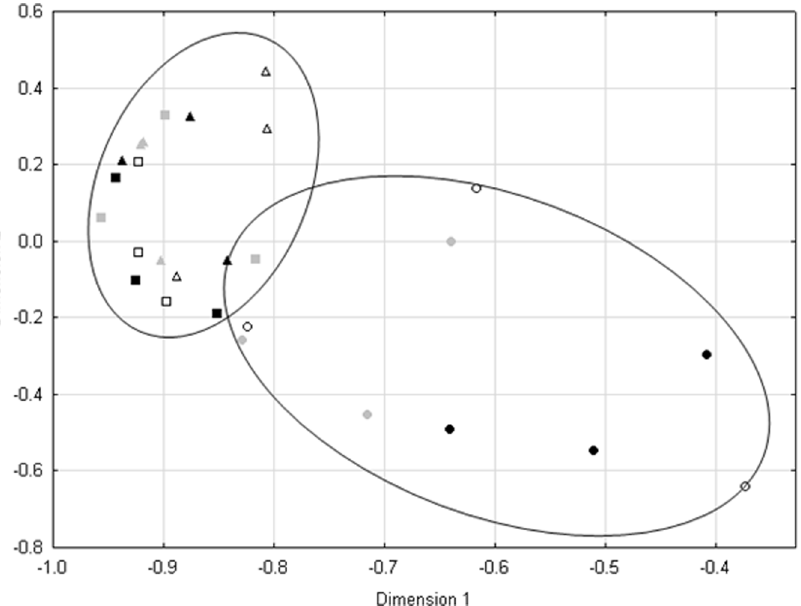
Figure 6. The terrestrial (squares) and dry bank (triangles) form a cluster, which samples showed under dispersion (measured with